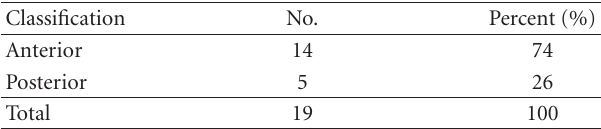
Table 3: Classification of